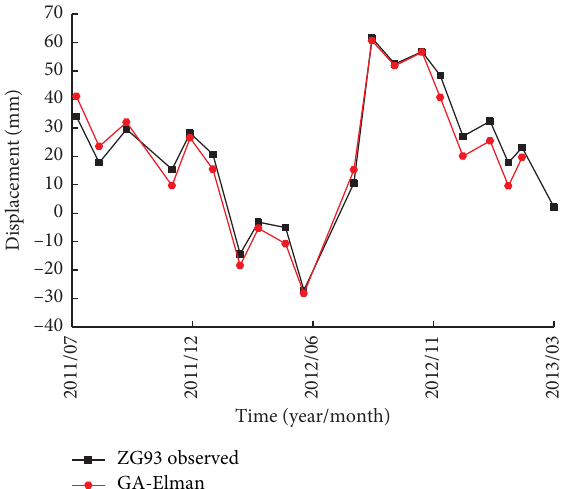
Figure 10: Prediction performance through the GA-Elman model on point ZG93 in the Baishuihe landslide displacement.